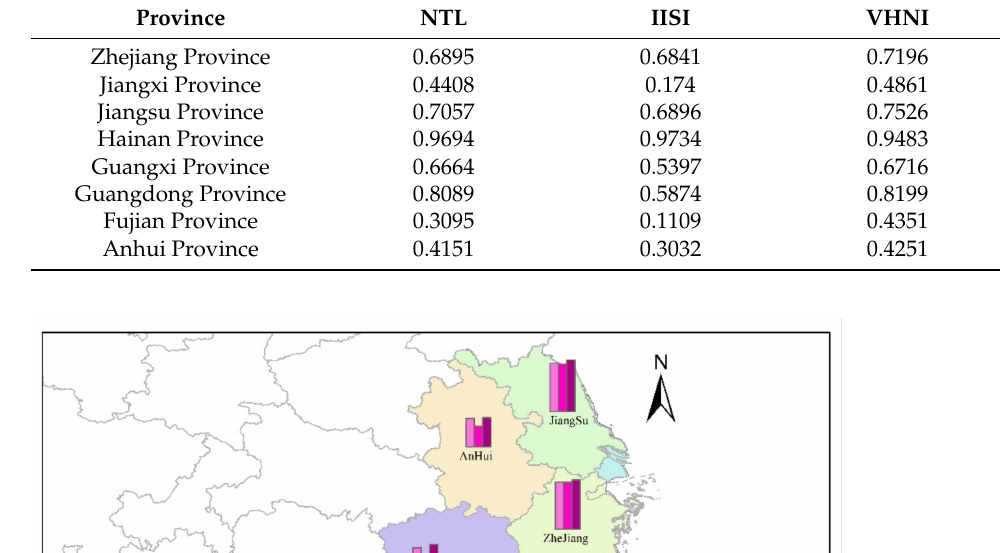
Table 7. Linear regression R 2 between TNL and power consumption within provinces.